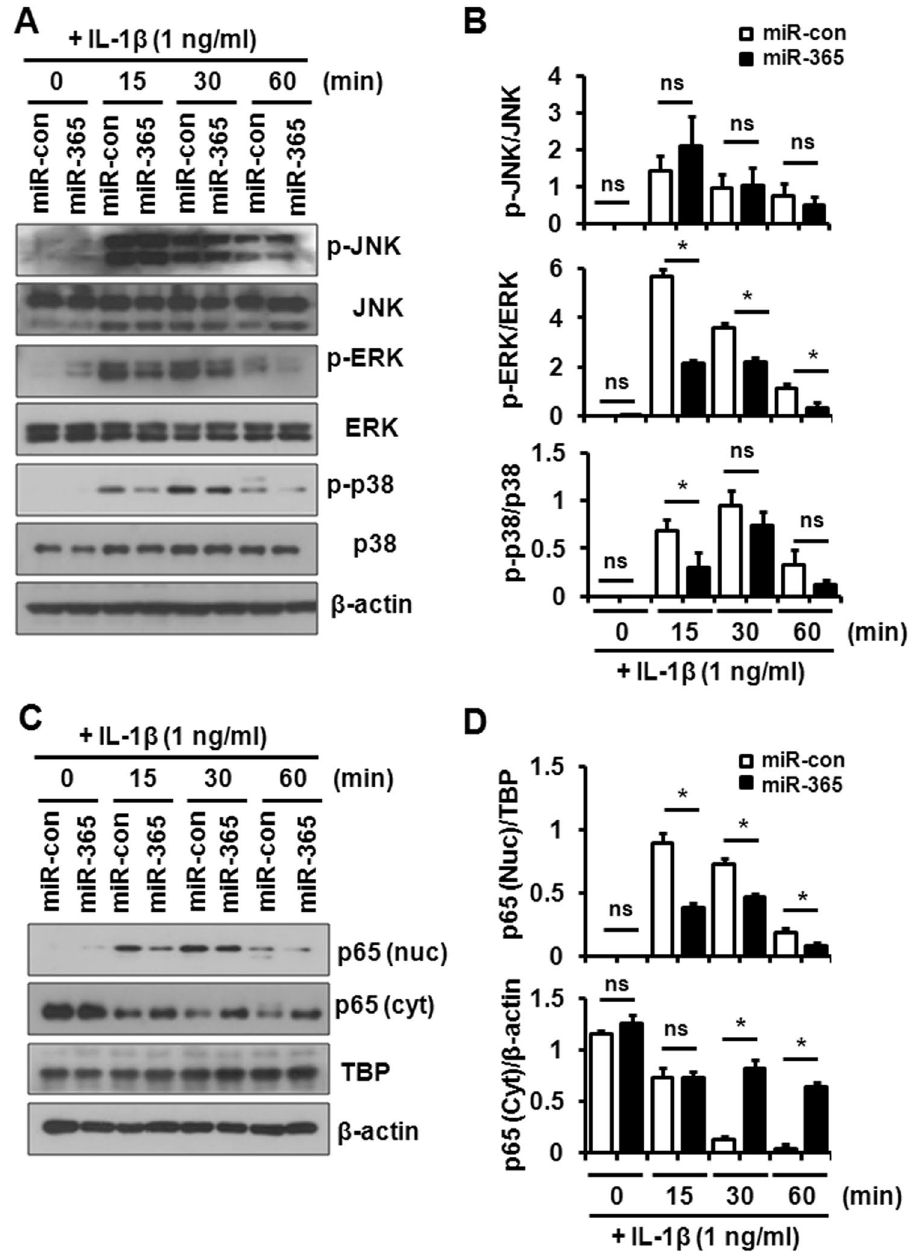
Figure 5. Effect of miR-365 on IL-1 β -activated signaling pathways in human chondrocytes. Human OA chondrocytes were transfected with miR-365 or a nonspecific control miRNA (miR-con) for 48 h and stimulated with IL-1 β (1 ng/mL) for 0, 15, 30, and 60 min. ( A ) Phosphorylation of Jun N-terminal kinase (JNK), extracellular signal-regulated kinase (ERK), and p38 and ( C ) translocation of p65 into the nucleus were analyzed by Western blot. Immunoblots shown are representative of more than three independent experiments. β -actin and TBP served as loading control. TBP, Tata-box binding protein. ( B ) The relative phosphorylation level of JNK, ERK, and p38 proteins and ( D ) the relative level of p65 in the nucleus and cytoplasm. Protein density was normalized to ( B ) the respective unphosphorylated proteins and ( D ) β -actin or TBP. Data are expressed as the mean ± SD of more than three independent experiments. ns, not significant, * P < 0.05 vs. miR- con-transfected